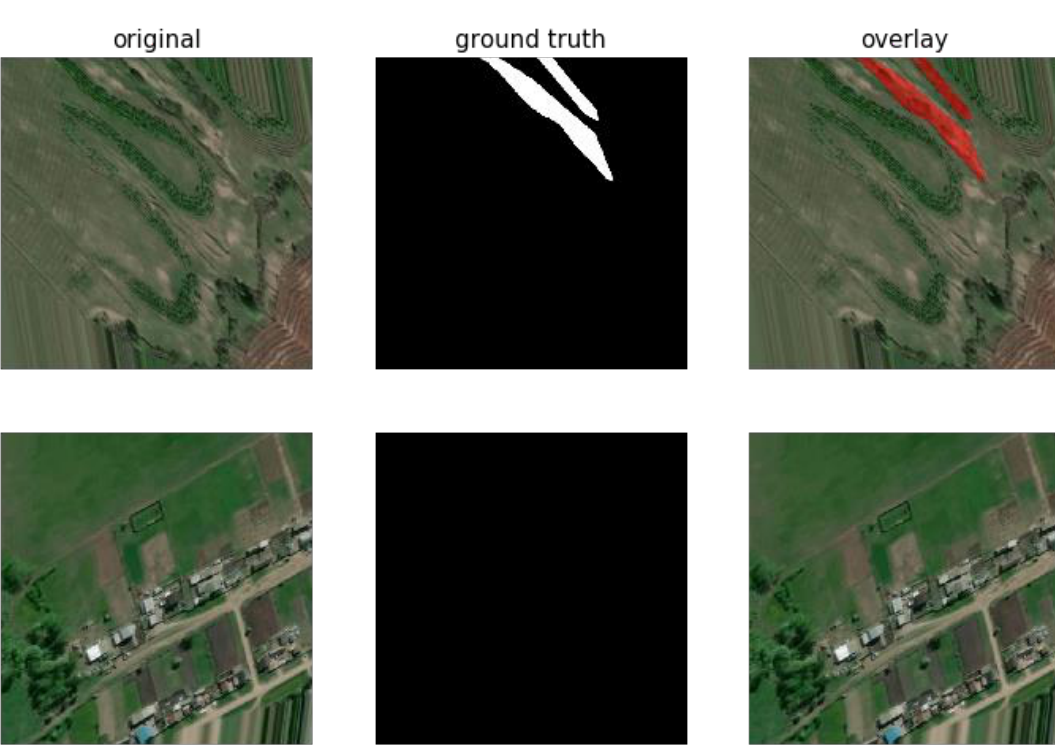
Figure 5. An example of a transformed training dataset.